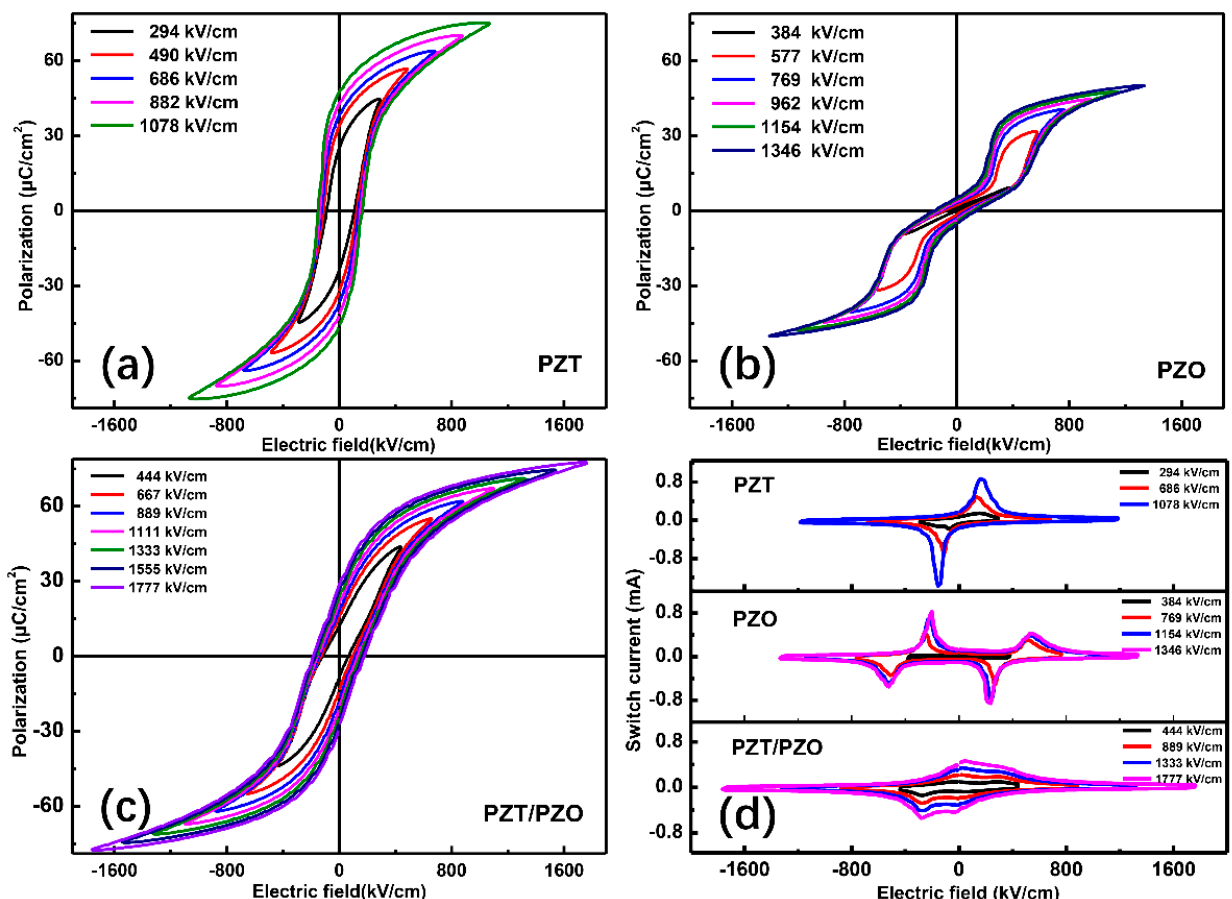
Figure 3. ( a – c ) Hysteresis loops of PZT, PZO, and PZT/PZO multilayer films; ( d ) the switch current with the electric fields of PZT, PZO, and PZT/PZO multilayer films at room temperature.